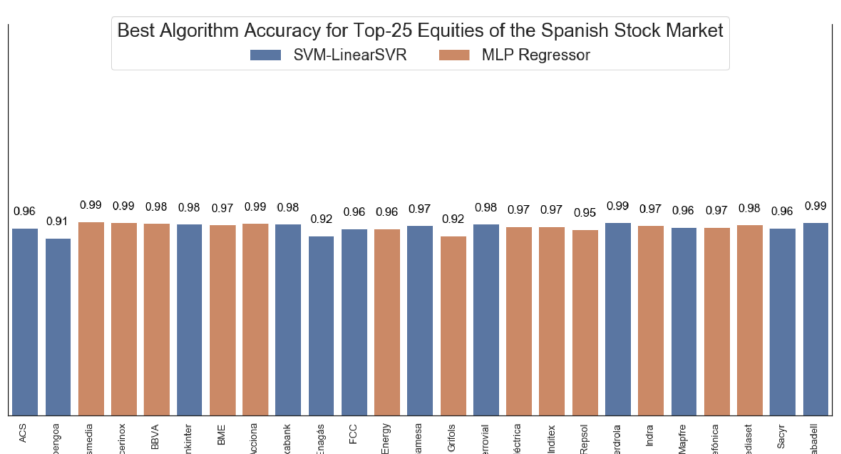
Figure 14. Best algortihm accuaracy for top-25 equities of the Spanish Continuous Stock